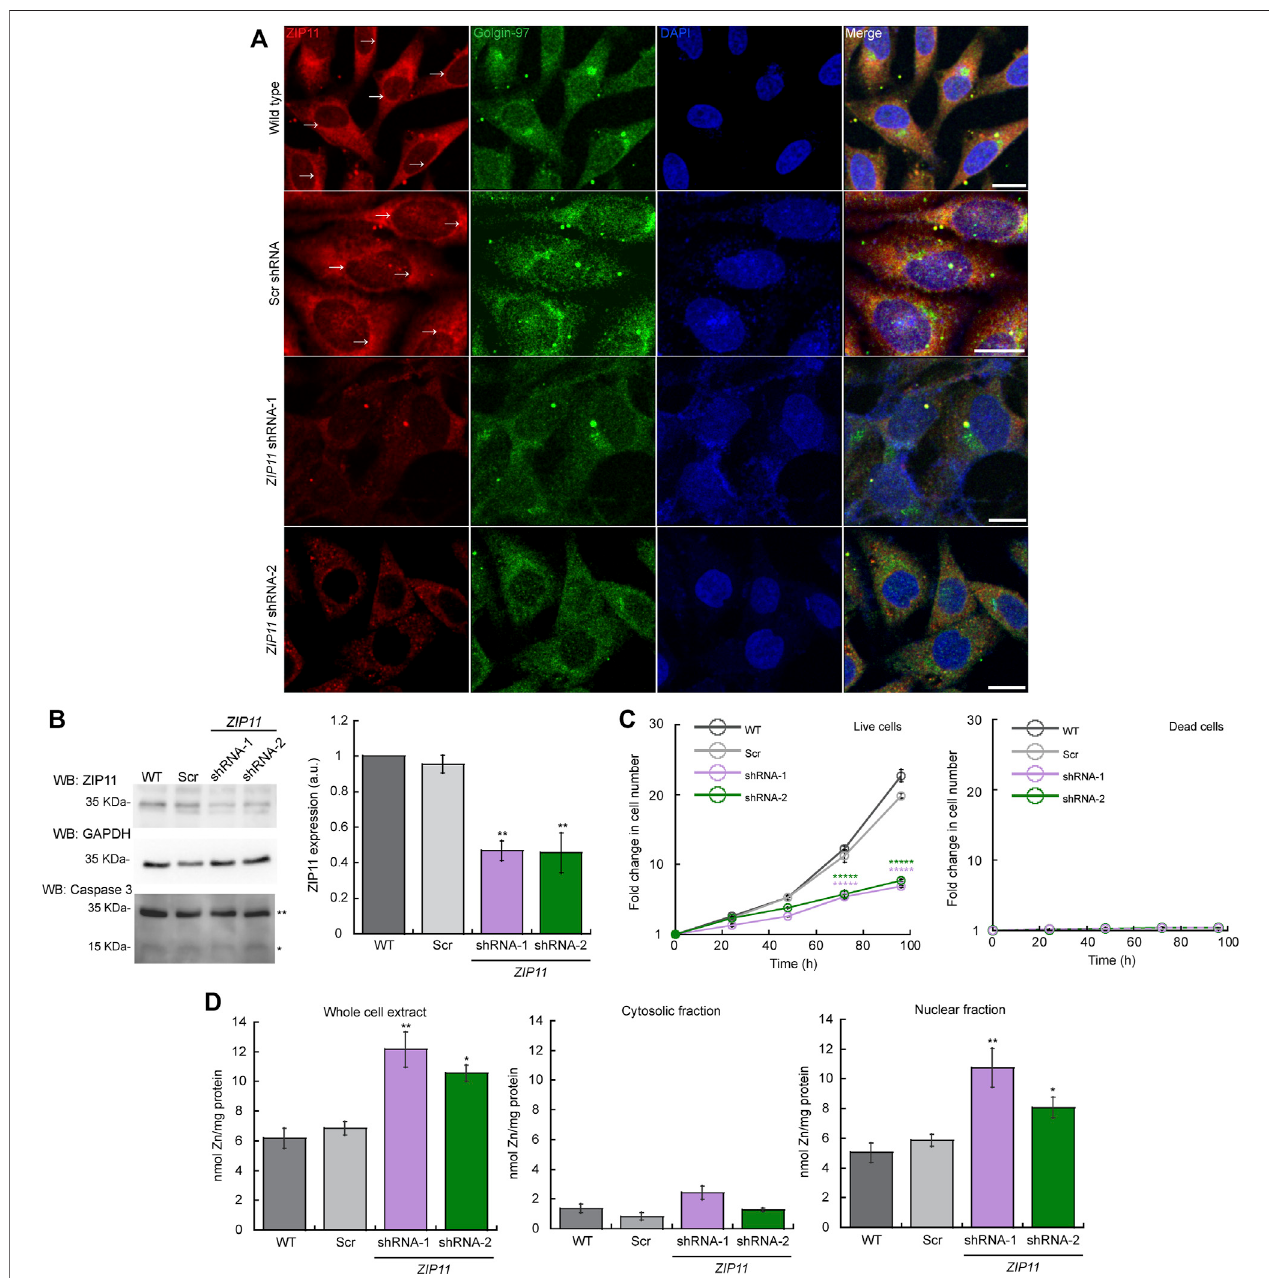
FIGURE 2 | ZIP11 is required for proliferation of HeLa cells and regulates nuclear levels of Zn. (A) Representative confocal images showing a perinuclear and cytosolic punctuated pattern of expression of ZIP11 (red) in wild type and scramble (Scr) shRNA transduced HeLa cells. Confocal images of HeLa cells transduced with ZIP11 shRNA-1 and shRNA-2 show a decrease in the staining around the nucleus and vesicles. shRNA1 and shRNA2 targets the CDS and UTR regions of ZIP11 , respectively.Theanti-Golgi-97antibody(green)wasusedasamarkerofGolgiapparatusandnucleiwasstainedwithDAPI(blue).Bar=10 µm. (B) Representative immunoblot(left) and quanti fi cation (right) of ZIP11 levelsofthe 35 KDa (isoform 1) inHeLaproliferatingcells for72 h. See Supplementary FigureS3 forthe dataofthe rest of isoforms. Immunoblots against GAPDH were used as loading controls. Samples were compared to the corresponding wild type sample. An anti-caspase 3 antibody was used to detect cell death in HeLa cells proliferating for 72 h; single asterisk (*) indicate cleaved caspase 3 and double asterisks (**) indicate the full inactive pro-caspase 3 form. (C) Cell counting assay of proliferating WT, and cells transduced with scrambled shRNA (shRNA Scr), or ZIP11 shRNAs. Data represent the fold changeinnumber ofliveand dead cellsasdetermined byTrypan blueassay. (D) Znlevelsin proliferating HeLacells.Wild type and cellsstably expressing Scr, shRNA-1 orshRNA-2against ZIP11 wereallowedtogrowfor48 handsubcellularfractionswereobtainedusingtheREAPprotocol.Wholecell(left)cytosolic(middle)andnuclear (right) Zn content determined by AAS (Suzuki et al., 2010; Gordon et al., 2019a; Tavera-Montañez et al., 2019). For all samples, data are the mean ± SE of three independent biological replicates. * p < 0.05; ** p < 0.01; ***** p < 0.00001.